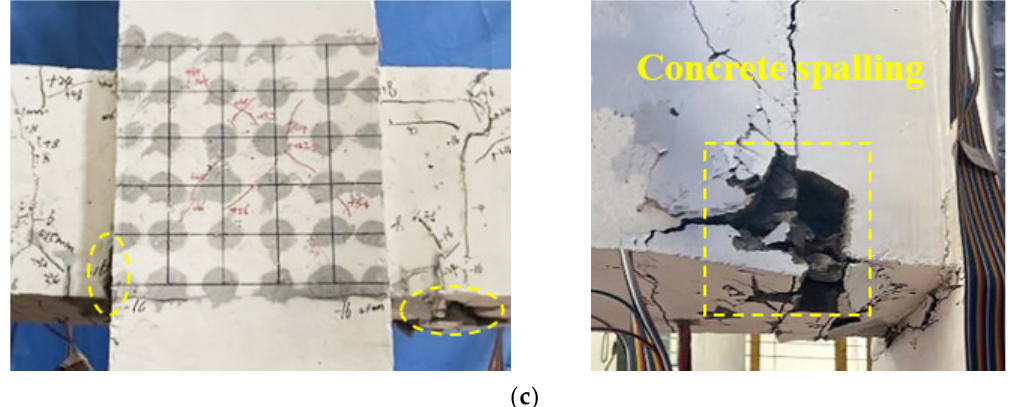
Figure 6. Failure modes of the three specimens. ( a ) Specimen J-RC; ( b ) Specimen PJ-ECC; ( c ) Specimen PJ-SMA-ECC.